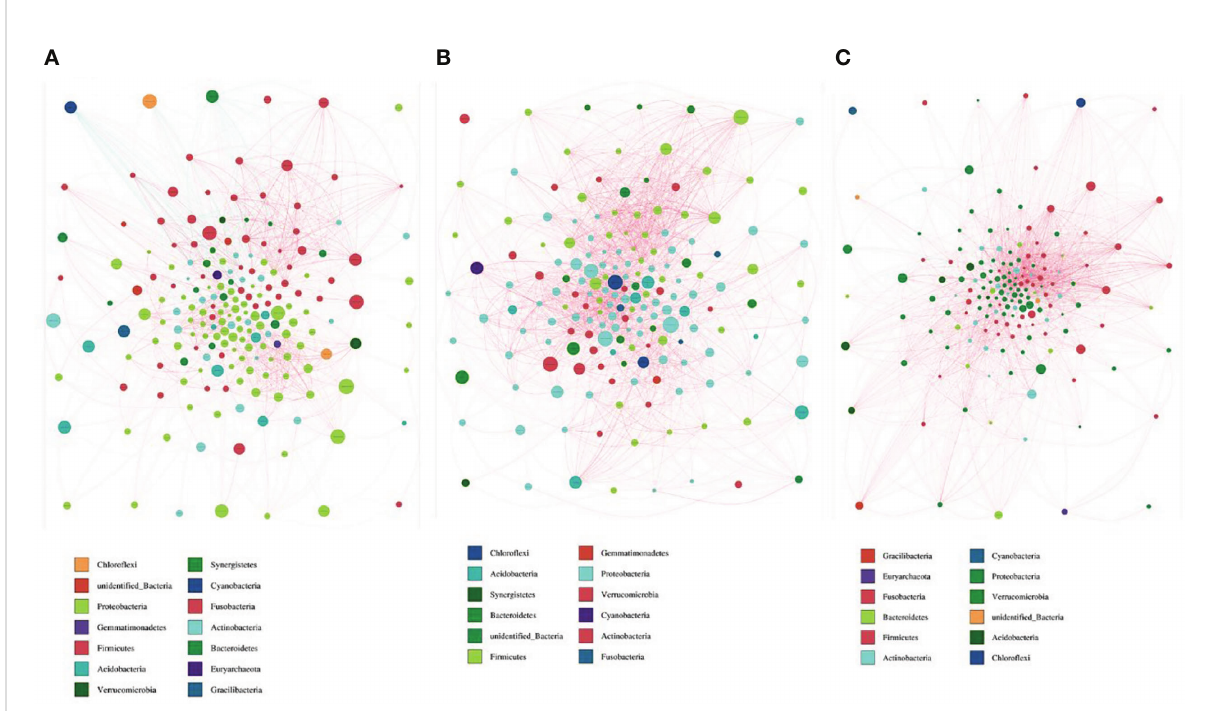
FIGURE 6 Bacterial interaction network diagram of nAGHp.b (A) , nAGHp.a (B) , EFHp.a (C) . Different nodes represent different genera, and node size represents the average relative abundance of the genus. The node color of the same door is the same genera. The thickness of the connection between nodes is positively correlated with the absolute value of the correlation coef fi cient of species interaction; the red line represents a positive correlation, and the blue line represents a negative